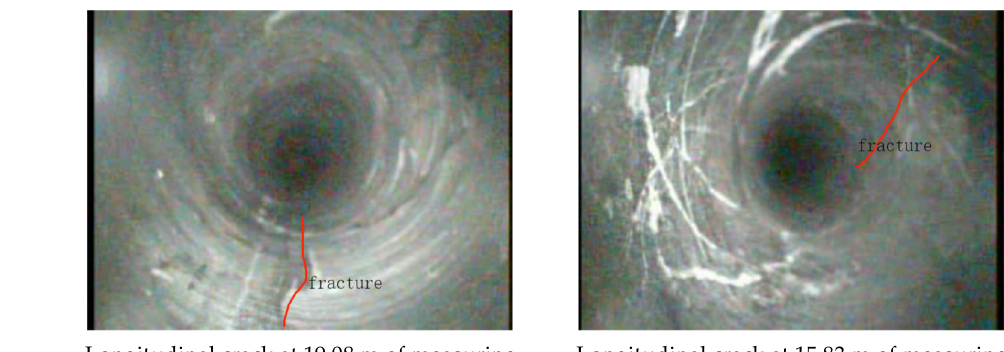
Figure 4. Peeping results of strata before mining in No. 5 hole 29 m away from the working face.